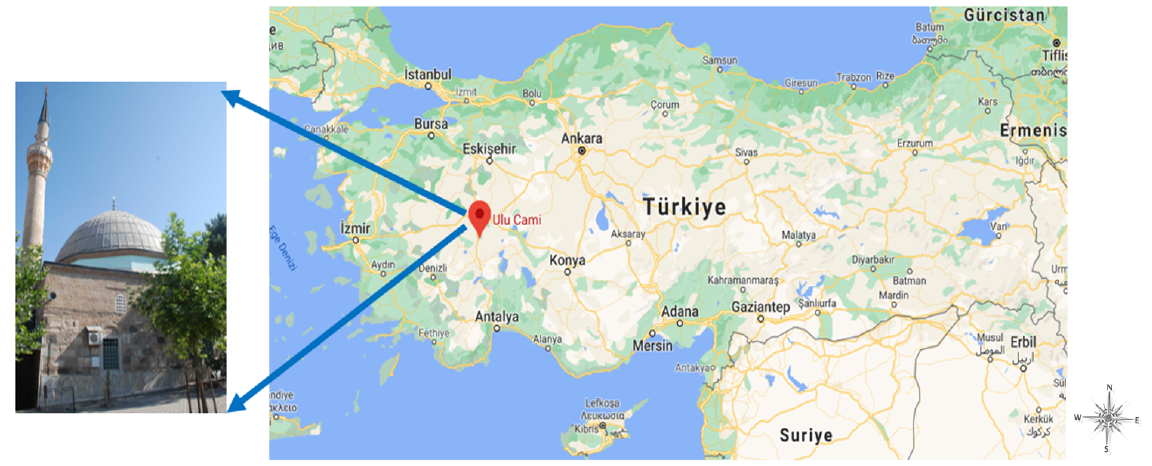
Figure 1. Ulu Mosque and its location in Turkey.